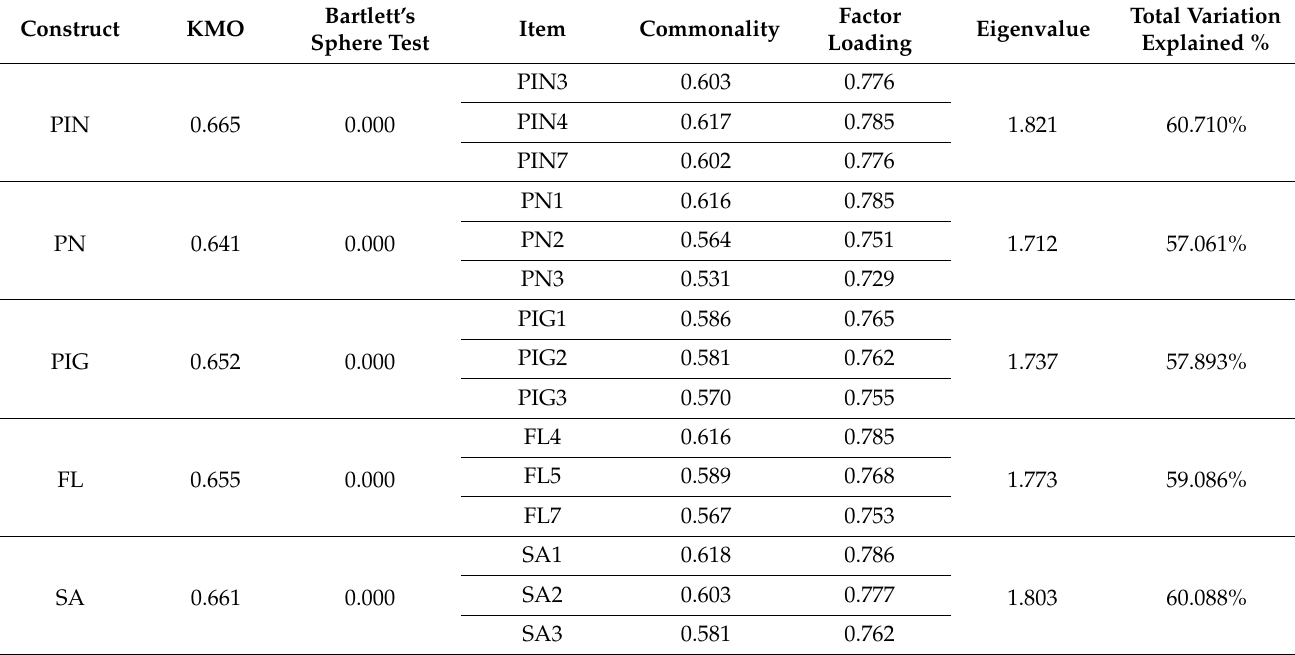
Table 6. Results of exploratory factor